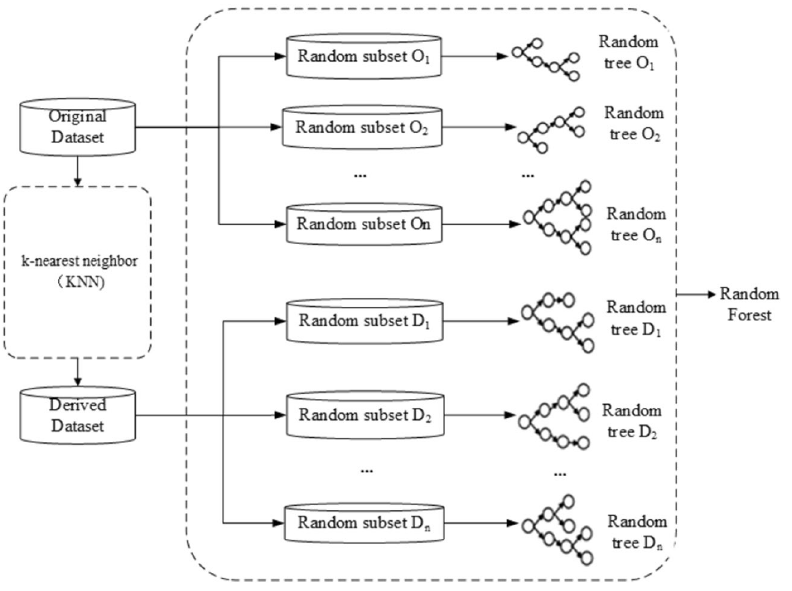
Figure 2. Schematic diagram of